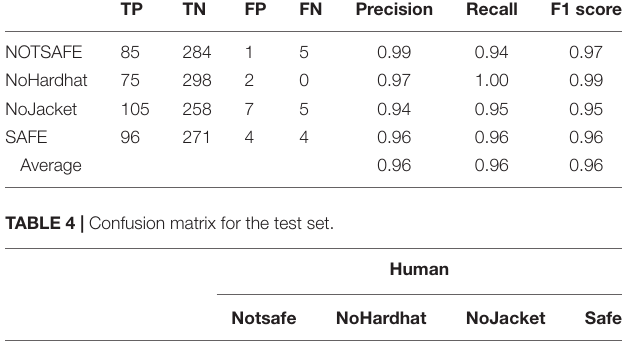
FIGURE 3 | Frames of video output, demonstrating change of classification.